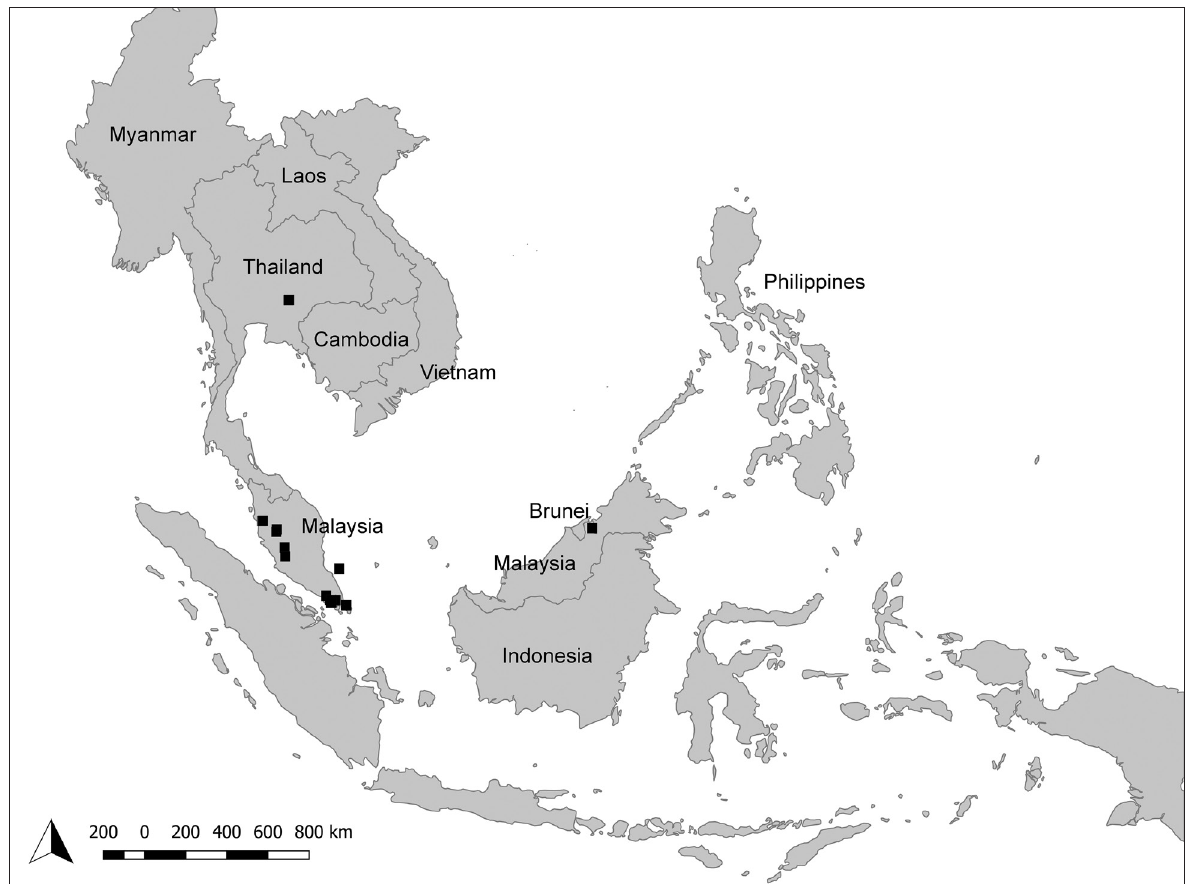
Fig. 1. Map of Southeast Asia with black squares indicating sampling locations between